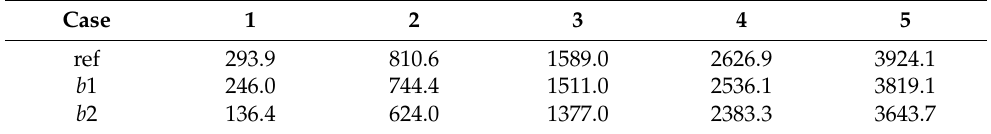
Table 7. The first five-mode frequencies under different thermal loads (Hz).